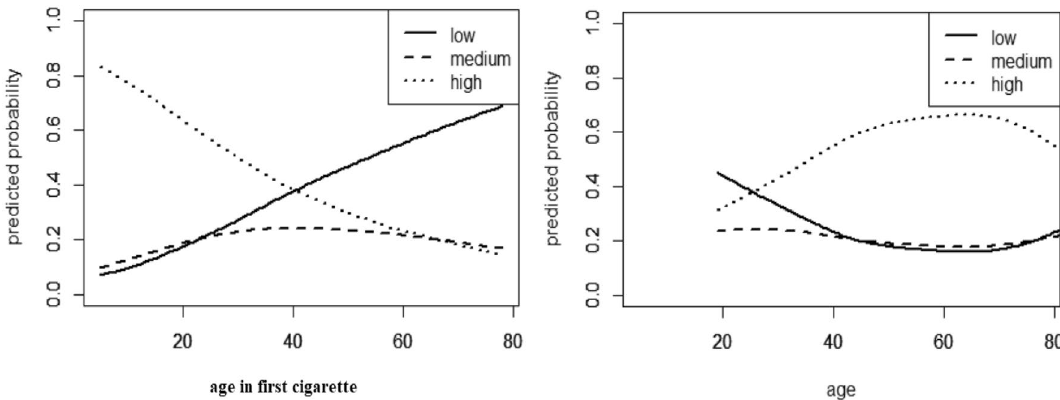
Figure 2. Plot of response probabilities in three groups with low, moderate, and heavy consumption vs. age at smoking onset (left) and age (right). The sum of the three probabilities is equal to